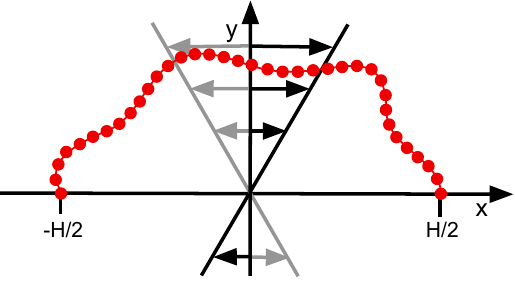
Figure 1. Sketch of the tethered bead-spring polymer exposed to oscillatory linear shear